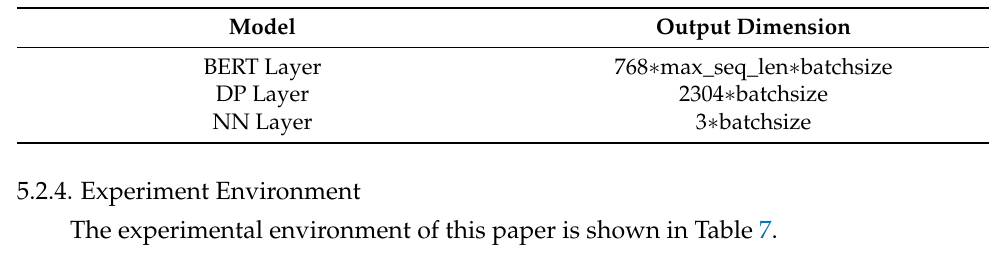
Table 6. BERT-DP network structure.